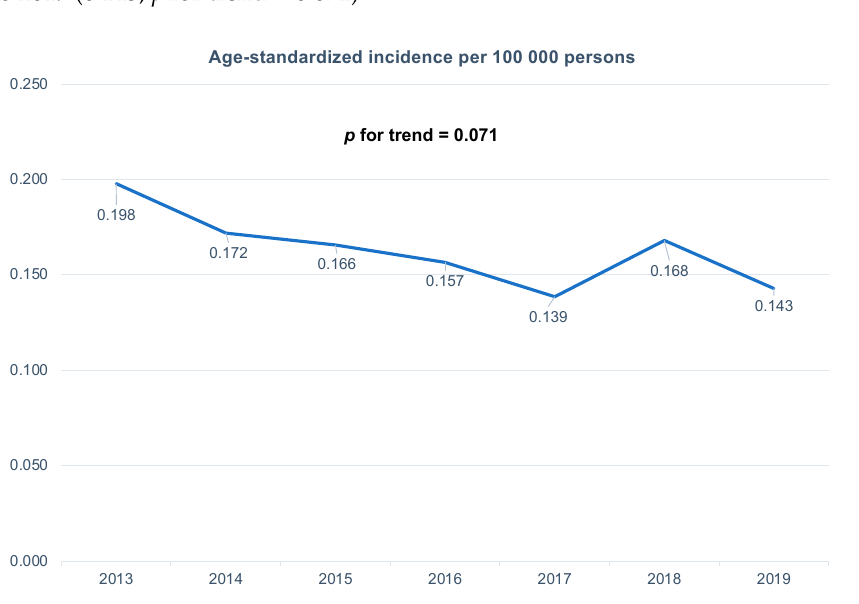
Figure 1. Flowchart depicting the selection of the study population. EMS = emergency medical service.